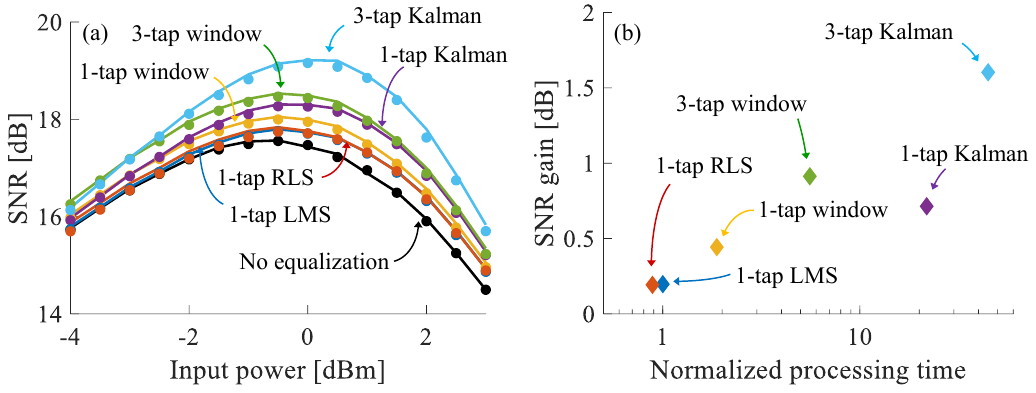
Figure 4. SNR improvement of different equalization algorithms. ( a ) SNR vs. power for each algorithm. The curves represent results obtained using the Virtual Lab tool [8], whereas the dots correspond to split-step simulations. ( b ) Peak SNR gain vs. computational cost, obtained by measuring the time that was needed to process a single set of symbols for each algorithm. The SNR gain is defined as the difference between the peak SNR of the unequalized case to those of the different